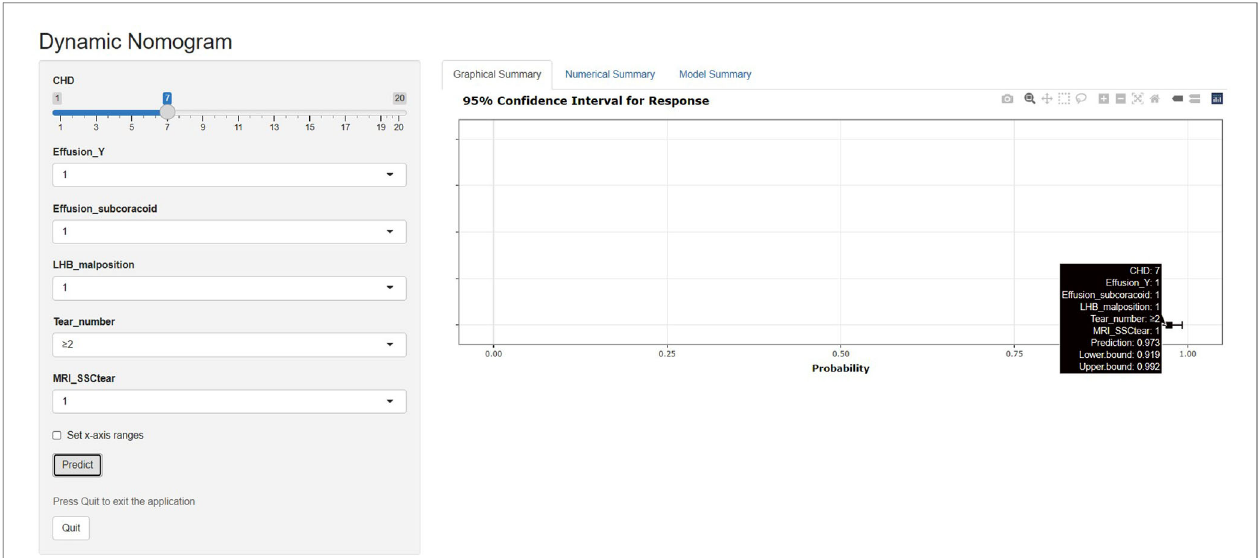
FIGURE 6 | Screenshot of the web-based dynamic nomogram used to predict SSC tendon tears (https://cmuxwn.shinyapps.io/DynNomapp/). This patient combined with effusion (Y-face), subcoracoid effusion, LHB malposition, multiple PS rotator cuff tears, 7 cm of CHD, and considering SSC tendon tears on MRI, and the predicted probability of SSC tendon tear was 97.3% (black